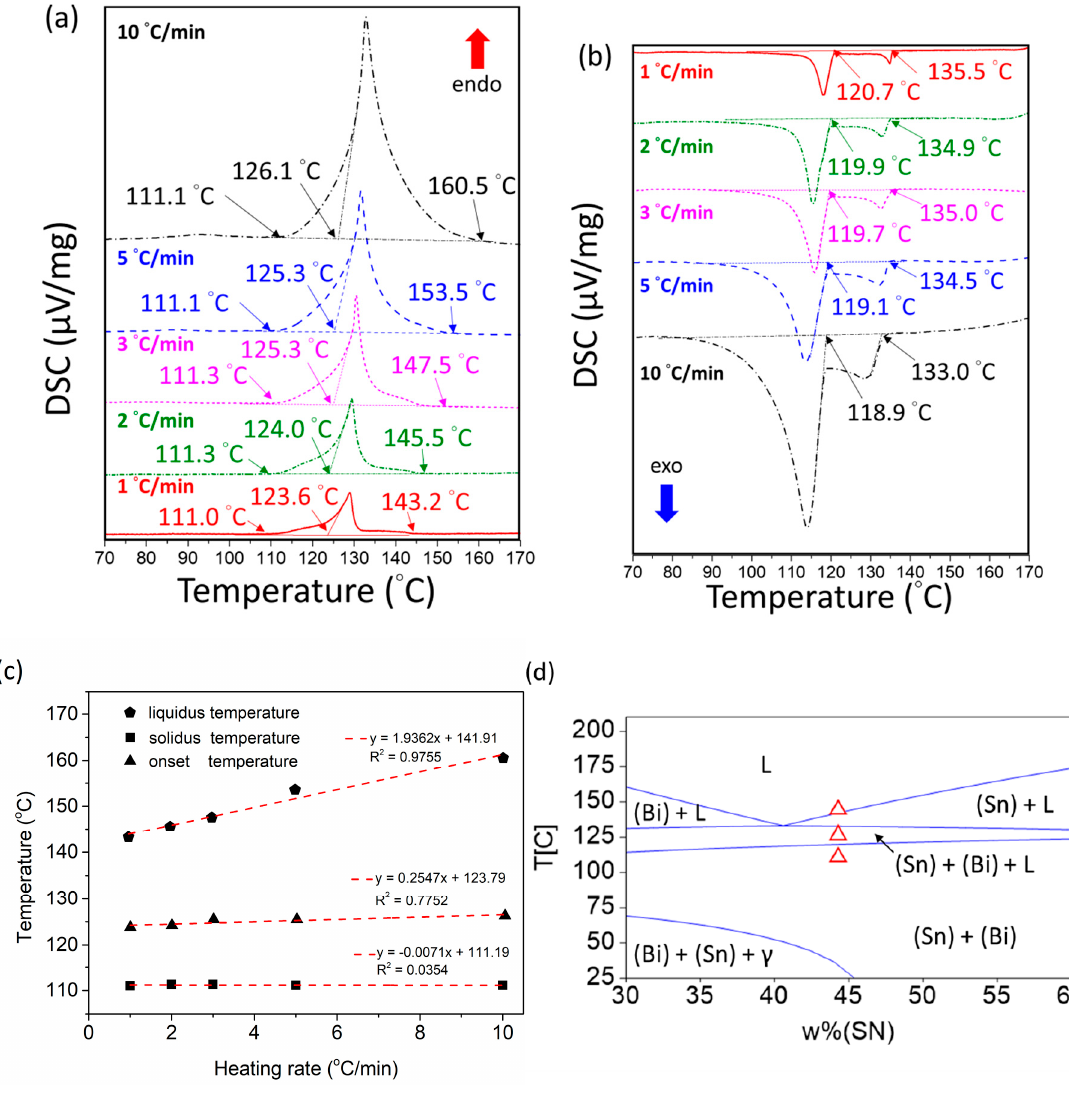
Figure 3. The differential scanning calorimetry (DSC) curves of 1, 2, 3, 5, and 10 °C/min in ( a ) the heating process and ( b ) the cooling process of the Sn-52.5Bi-2.68In-1Ga (SBIG) alloys. ( c ) The linear extrapolations of T S , T 0 , and T L . ( d ) The calculated isoplethal section of Sn–53.5Bi–2.71In with superimposed T S , T 0 , and T L .